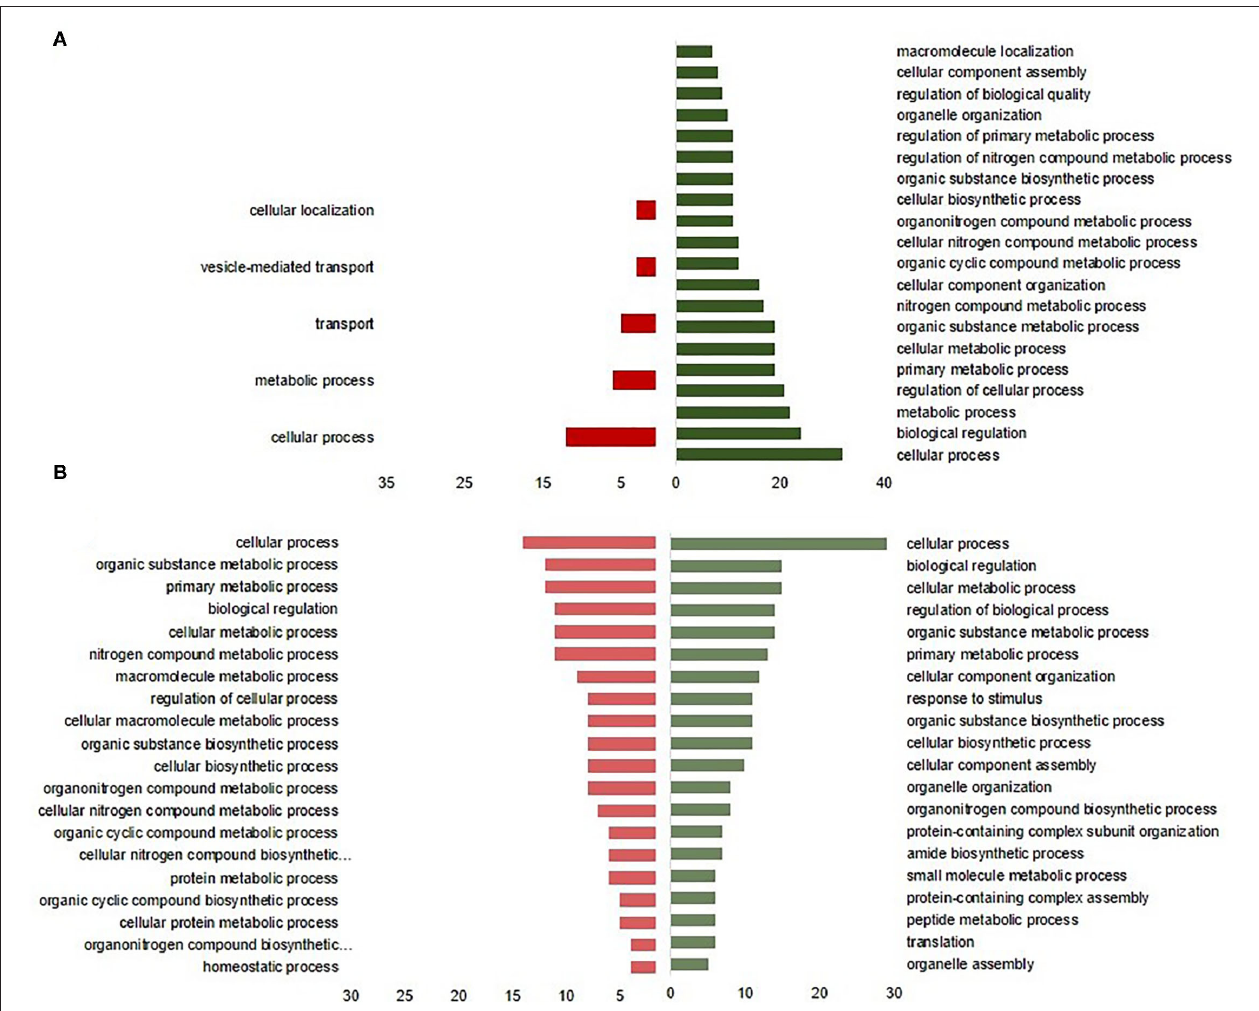
FIGURE 4 | Enrichment of biological process of intestinal differentially expressed proteins from broilers exposed to Citrobacter spp. (C2) in ovo (A) at the day of hatch and (B) by 10 days of age. The green bars to the right indicate the most GO-enriched terms by upregulated proteins. The red bars to the right represent GO terms enriched by downregulated proteins, while the axis at the bottom is the number of proteins attributed to each GO